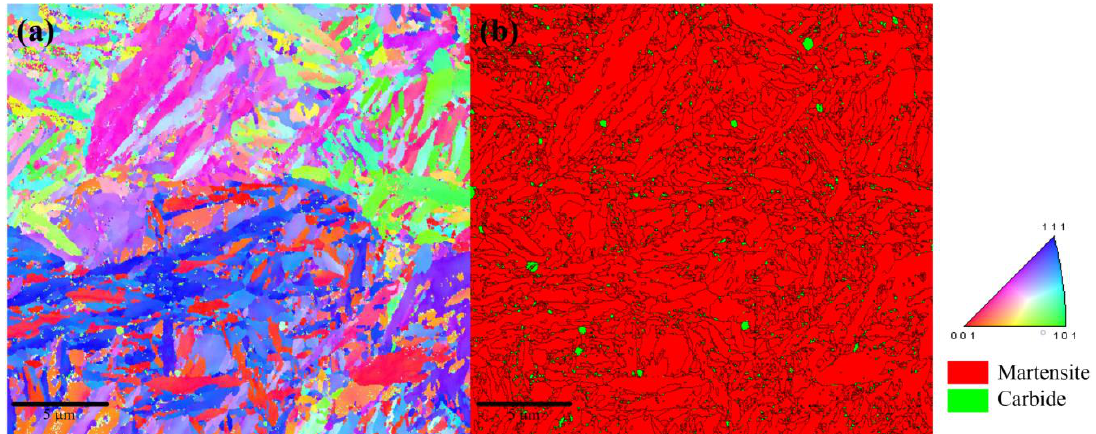
Figure 3. ( a ) Inverse pole figure of the Cr4Mo4V steel; ( b ) distribution map of phases.